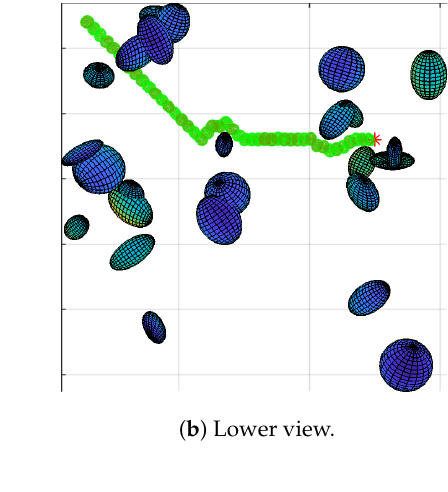
( c ) Side view. Figure 9. Path of map 2 generated with TLBO. The green ellipsoids represent the drone path and the multicolor ellipsoids represent the obstacles. Although it shows difficulties to find a path, it is safely pushed away the obstacles at the start.